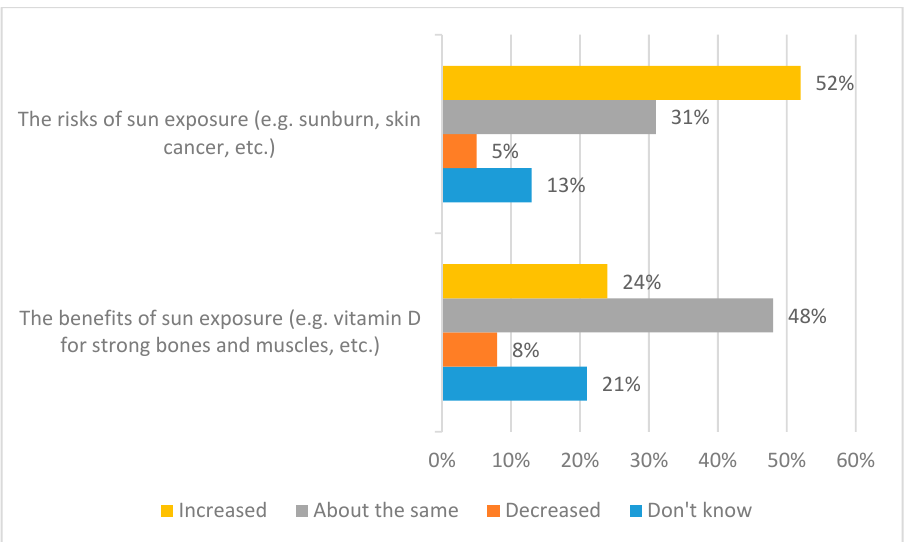
Figure 1. Public awareness of the promotion of the risks and benefits of sunlight exposure.